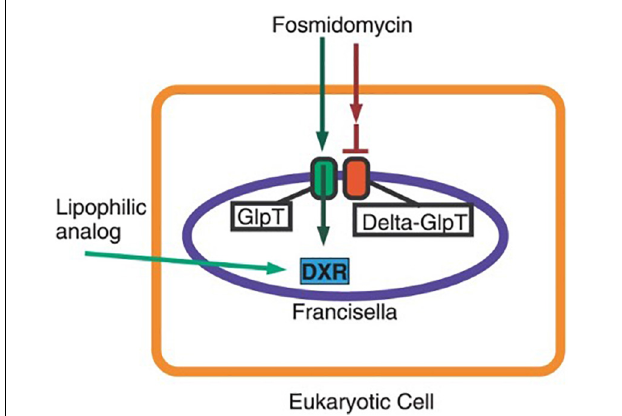
FIGURE 3 | Model for screening method to identify lipophilic, fosmidomycin-derived analogs effective against intracellular pathogens. Figure used under Creative Commons Attribution (CC BY 4.0) license (McKenney et al., 2012). In this system, the mammalian cell (orange line) is infected with intracellular bacteria (purple line), F. novicida (green GlpT protein), or F. novicida glpT mutant (red GlpT protein) separately. We demonstrated that the drug fosmidomycin is dependent on GlpT transporter to reach its intracellular target (DXR) in Francisella. This model demonstrates how we can use a mutant in a drug transporter in Francisella (blue cell) to screen for fosmidomycin analogs and prodrugs that act (i) independently of that transporter and (ii) are lipophilic and (iii) able to pass through both a bacterial membrane and (iv) a eukaryotic host cell membrane. Shown here is the difference between the parent compound fosmidomycin, which can pass through the host cell membrane, but requires Francisella GlpT to enter the bacteria, vs a lipophilic analog, which can pass through the host cell membrane and the bacterial cell membrane and can act on the drug target (DXR). The library of fosmidomycin analog candidates was first generated by testing candidate molecules against recombinant purified Francisella DXR in vitro (Jawaid et al., 2009). This intracellular model is constructed by infecting host cells with a glpT mutant of Francisella , and then screening a library of fosmidomycin analogs for inhibition of Francisella growth comparing the wild-type F. novicida vs the glpT mutant F. novicida for intracellular replication ( 123